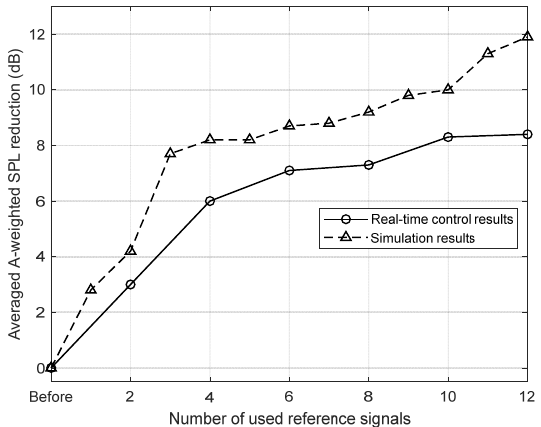
Figure 8. Comparison of the averaged reduction levels against the number variation of the reference signals. Computer simulation (dashed line with triangles). Actual real-time control experiment (solid line with circles).